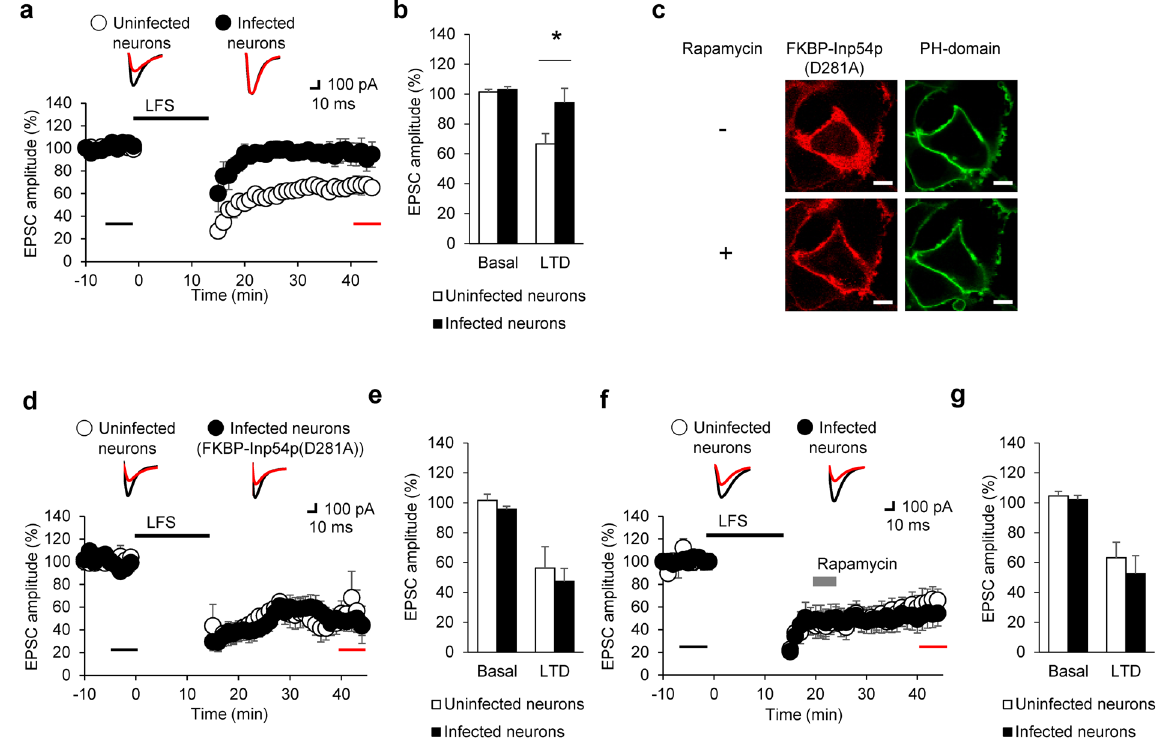
Figure 6. Acute PIP 2 reduction disrupted induction but not expression of LTD. ( a ) Normalized EPSC amplitudes when PIP 2 depletion occurred before the LTD induction. Rapamycin treatment was made prior to the beginning of the recording. Inserts: representative traces with color- matched time points. ( b ) Mean EPSC amplitudes before and after LTD induction in CA1 neurons for each group (Rapamycin ( − ): uninfected 101.44 ± 1.84%, N = 7, n = 9 vs . infected 103.15 ± 1.87%, N = 5, n = 5, p > 0.1; Rapamycin ( + ): uninfected 66.62 ± 6.91%, N = 7, n = 9 vs . infected 94.22 ± 9.62%, N = 5, n = 5, * p < 0.05, Mann-Whitney U-test). ( c ) Representative images of a HEK293T cell expressing LDR, FKBP-Inp54p(D281A) (red), and PH-domain (green) before and after 100 nM rapamycin treatment. Scale bars: 5 μ m. ( d ) Normalized EPSC amplitudes from FKBP-Inp54p(D281A)-expressing neurons. Rapamycin treatment was made prior to the beginning of the recording. Inserts: representative traces with color- matched time points. ( e ) Mean EPSC amplitudes before and after LTD induction in CA1 neurons for each group (Rapamycin ( − ): uninfected 101.73 ± 4.10%, N = 4, n = 4 vs . infected 95.64 ± 2.18%, N = 3, n = 5, p > 0.1; Rapamycin ( + ): uninfected 56.40 ± 14.27%, N = 4, n = 4 vs . infected 47.42 ± 8.68%, N = 3, n = 5, p > 0.1, Mann-Whitney U-test). ( f ) Normalized EPSC amplitudes when PIP 2 depletion occurred during the LTD expression. Rapamycin treatment occurred during LTD expression (gray bar). Inserts: representative traces with color- matched time points. ( g ) Mean EPSC amplitudes before and after the LTD induction in CA1 neurons for each group (Rapamycin ( − ): uninfected 104.61 ± 2.89%, N = 5, n = 6 vs . infected 102.22 ± 2.79%, N = 7, n = 7, P > 0.1; Rapamycin ( + ): uninfected 63.24 ± 10.47% N = 5, n = 6 vs . infected 52.78 ± 11.88%, N = 7, n = 7, p > 0.1, Mann-Whitney U-test). Error bars show mean ± SEM. All amplitudes of EPSCs are normalized to basal recording for 10 min before LTD induction by LFS (upper black